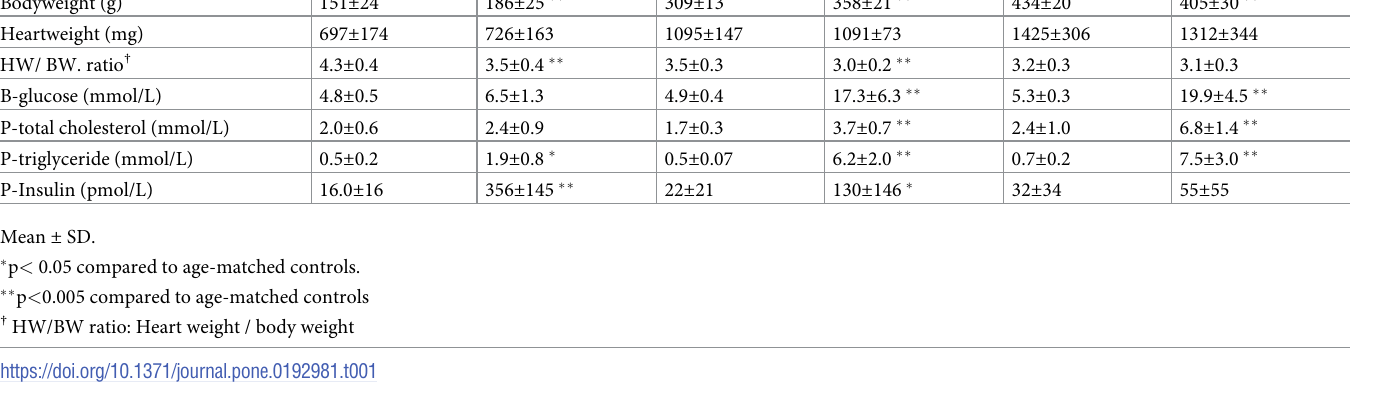
not differ from the entire cohort, indicating that we did not introduce significant selection bias (S1 Table).